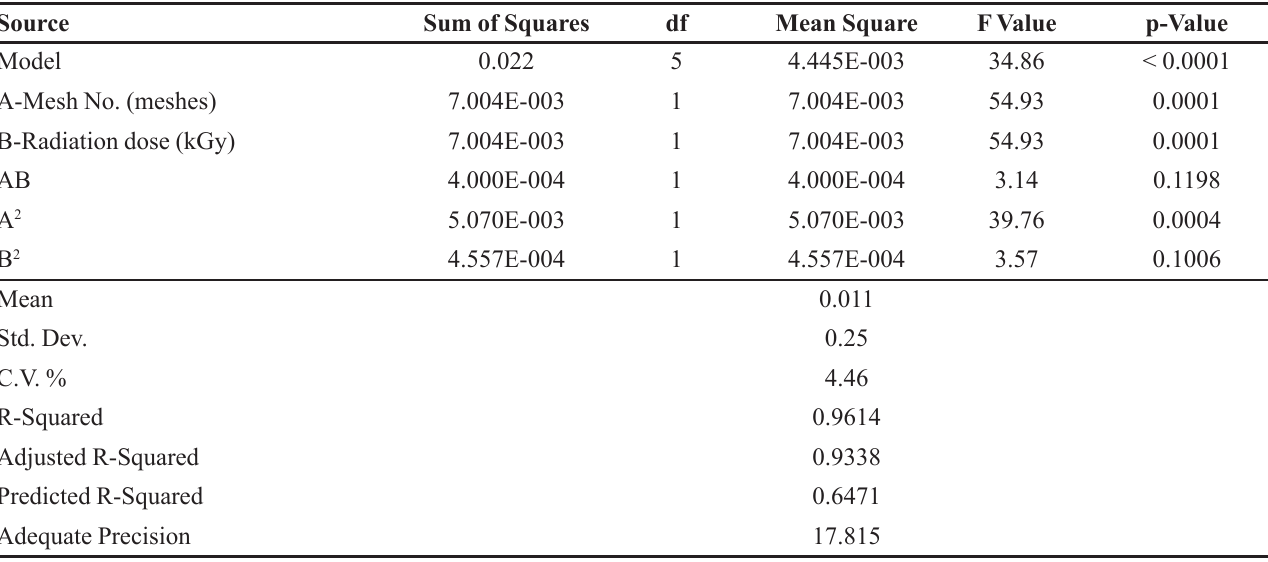
TABLE IIC - Analysis of variance (ANOVA) from the final reduced models for reducing power of gamma irradiated maize flour